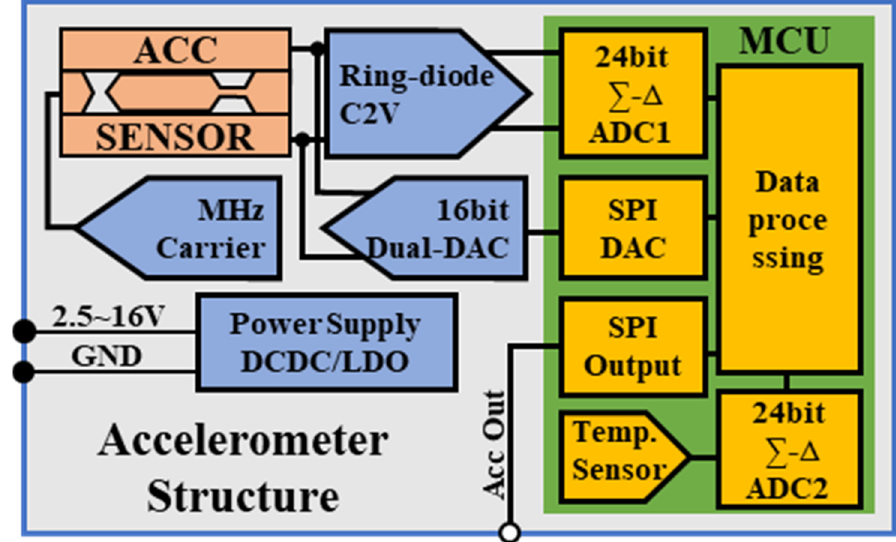
Figure 5. Closed-loop functional diagram.